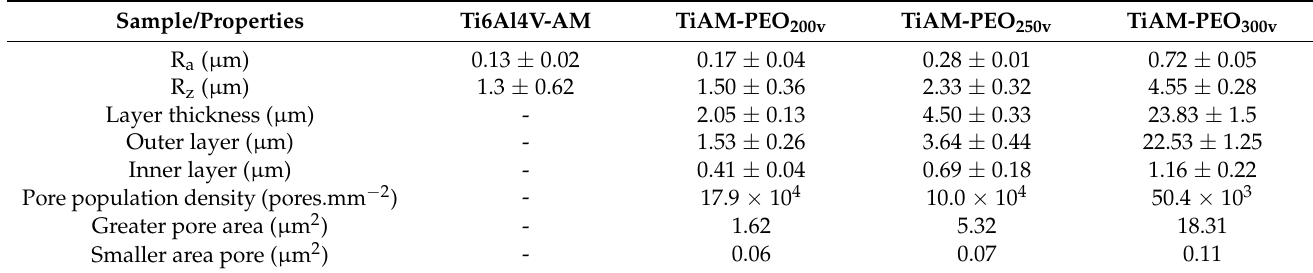
Table 1. Surface characteristics (roughness, thickness, and